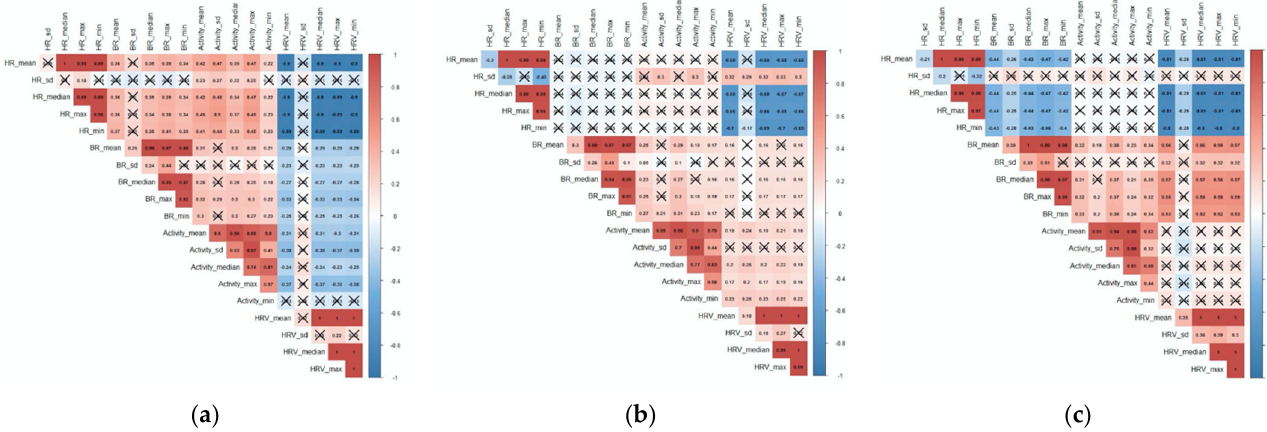
Figure 7. ( a ) Correlation between Non-Verbal Cues (NVC) physiological data during the compliant condition (HR = heart rate, BR = breathing rate, HRV = heart rate variability, sd = standard deviation). ( b ) Correlation between NVC physiological data during the partially compliant condition (HR = heart rate, BR = breathing rate, HRV = heart rate variability, sd = standard deviation). ( c ) Correlation between NVC physiological data during the non-compliant condition (HR = heart rate, BR = breathing rate, HRV = heart rate variability, sd = standard deviation).